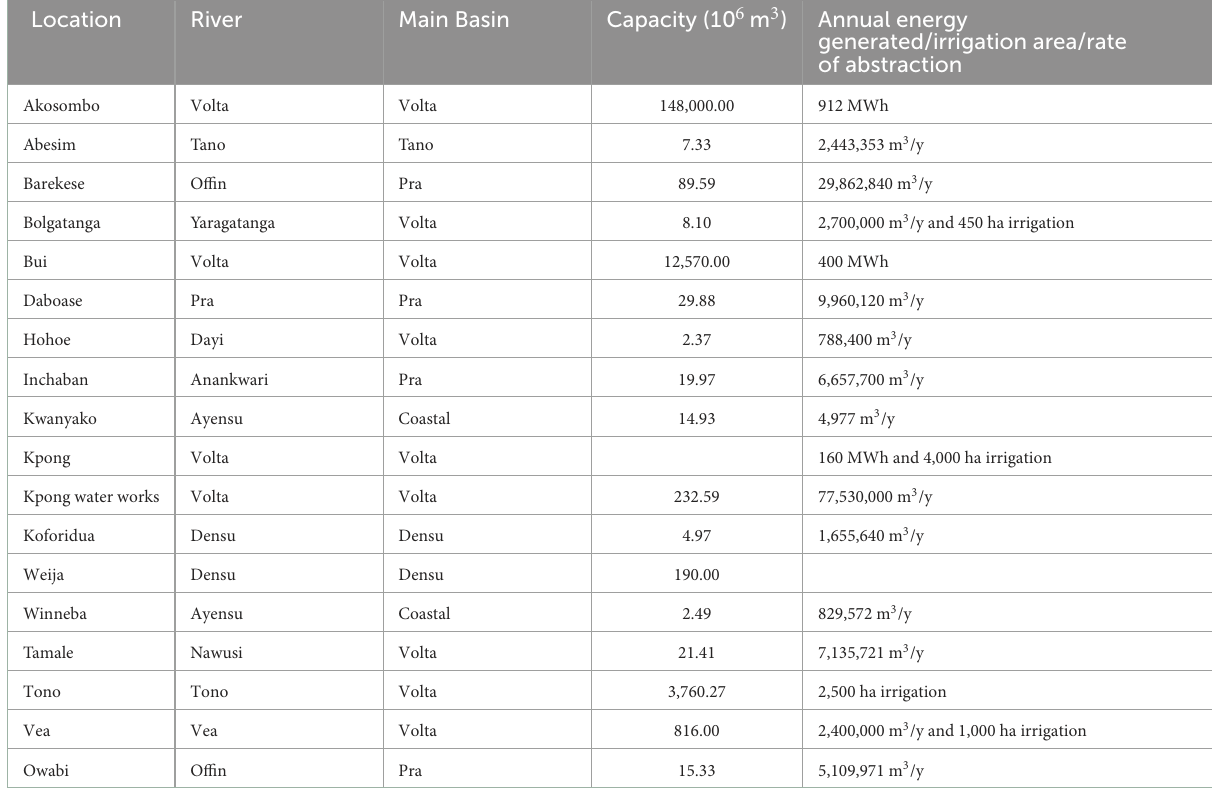
TABLE 2 Characteristics of some major reservoirs or impoundments in Ghana and their estimated annual generation rate or irrigation surface or abstraction rate.